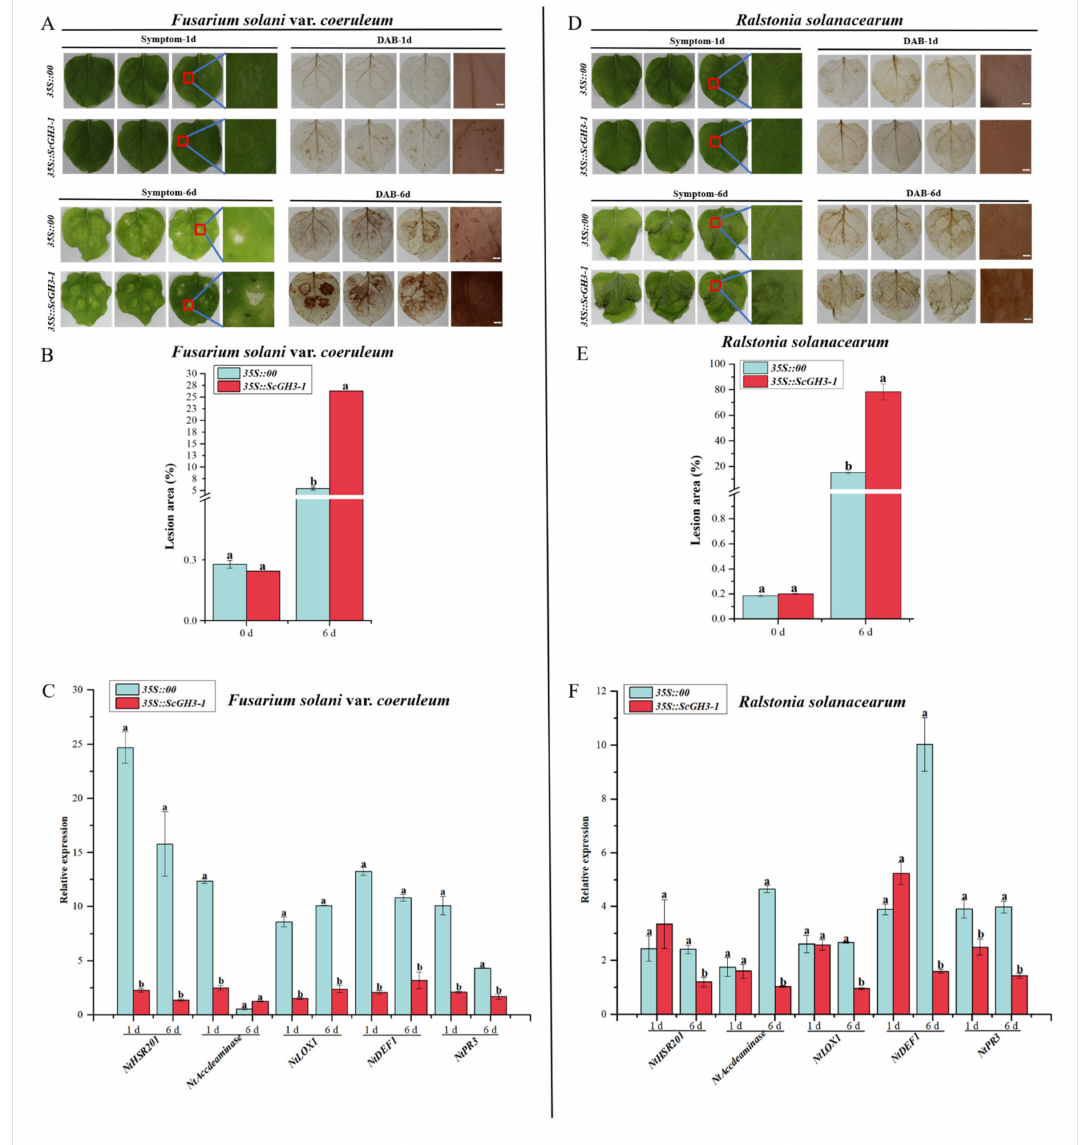
Figure 11. Resistance effect of the transient overexpression of ScGH3-1 in N. benthamiana leaves. ( A – D ) Phenotype and DAB staining of N. benthamiana leaves after inoculation with Ralstonia